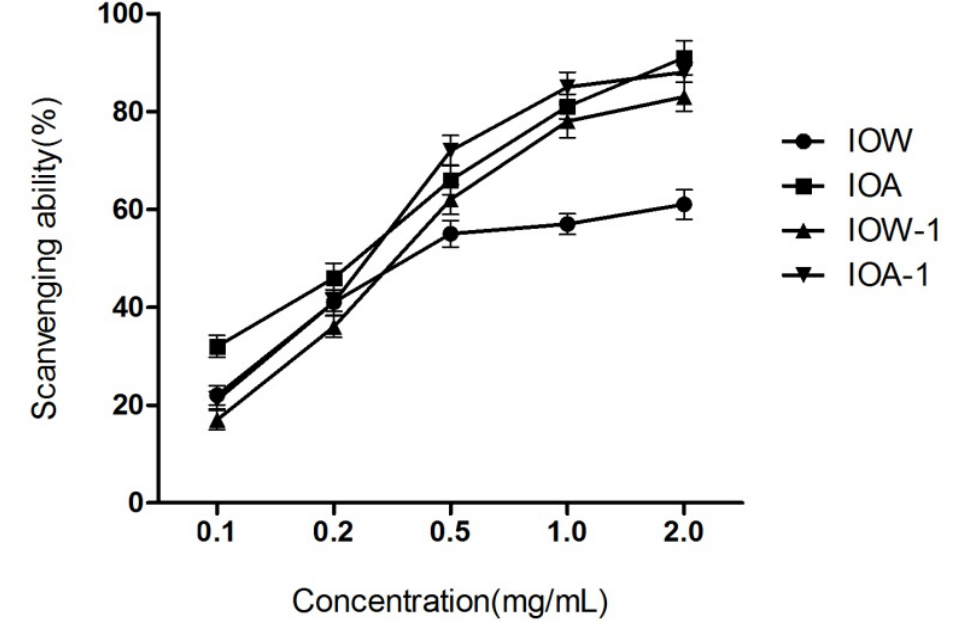
Figure 1. Scavenging ability on DPPH